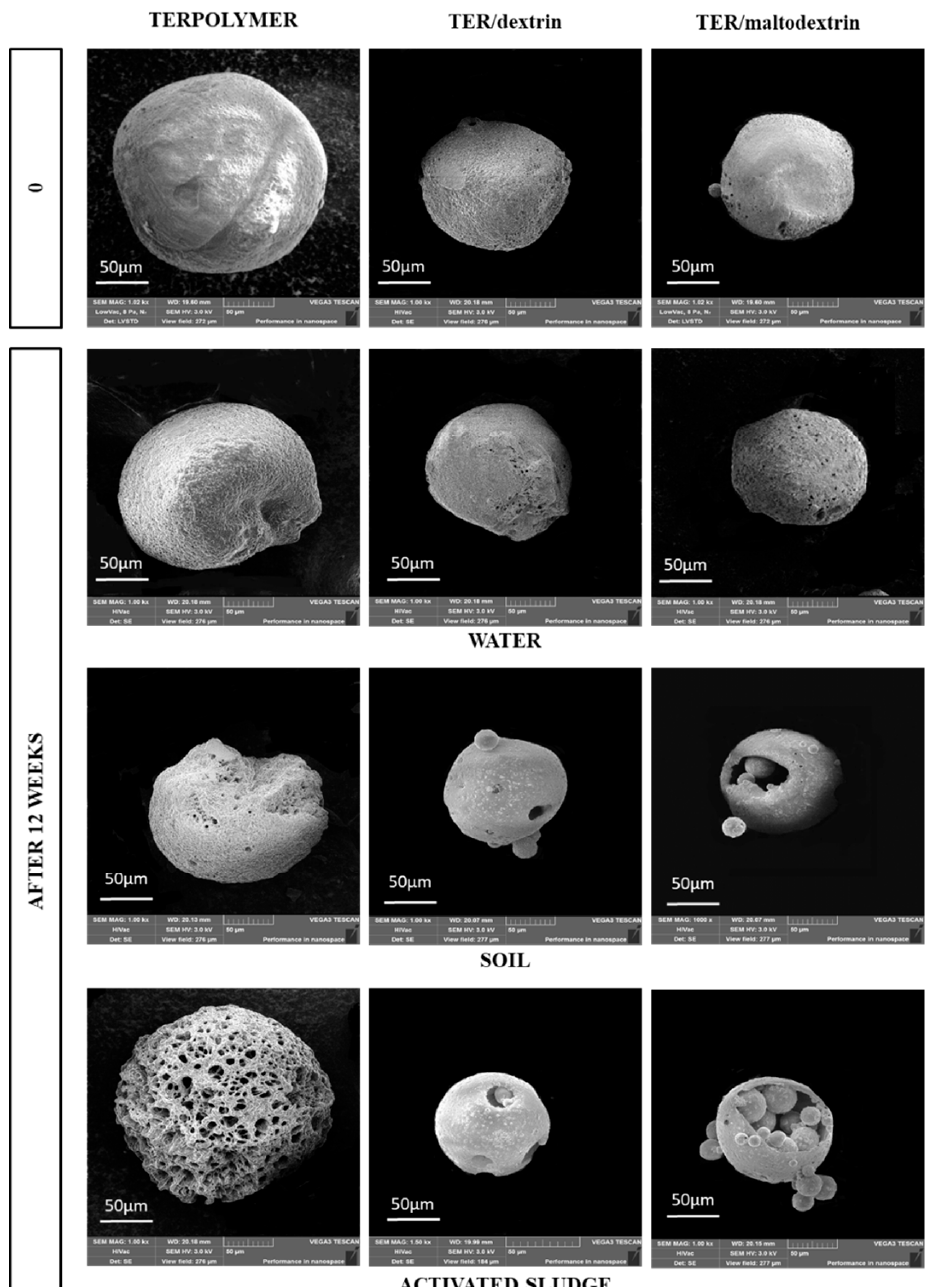
Figure 5. Deterioration of the microspheres surface after each period of exposure to the degradation medium, scanning electron microscopy (SEM) (magnification ×